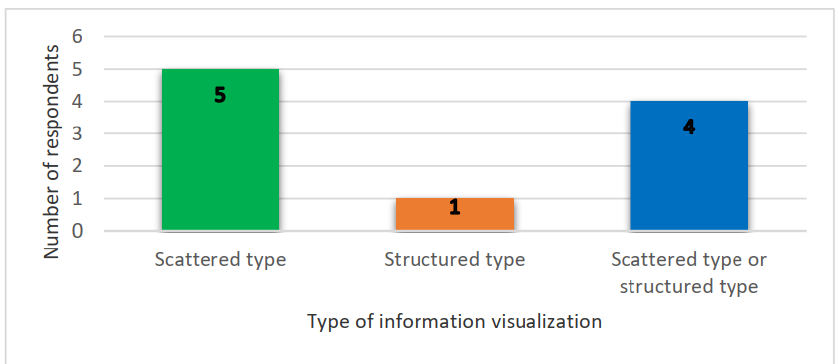
Figure 4. The test participant’s preferences on information visualization of large displays in a museum environment.